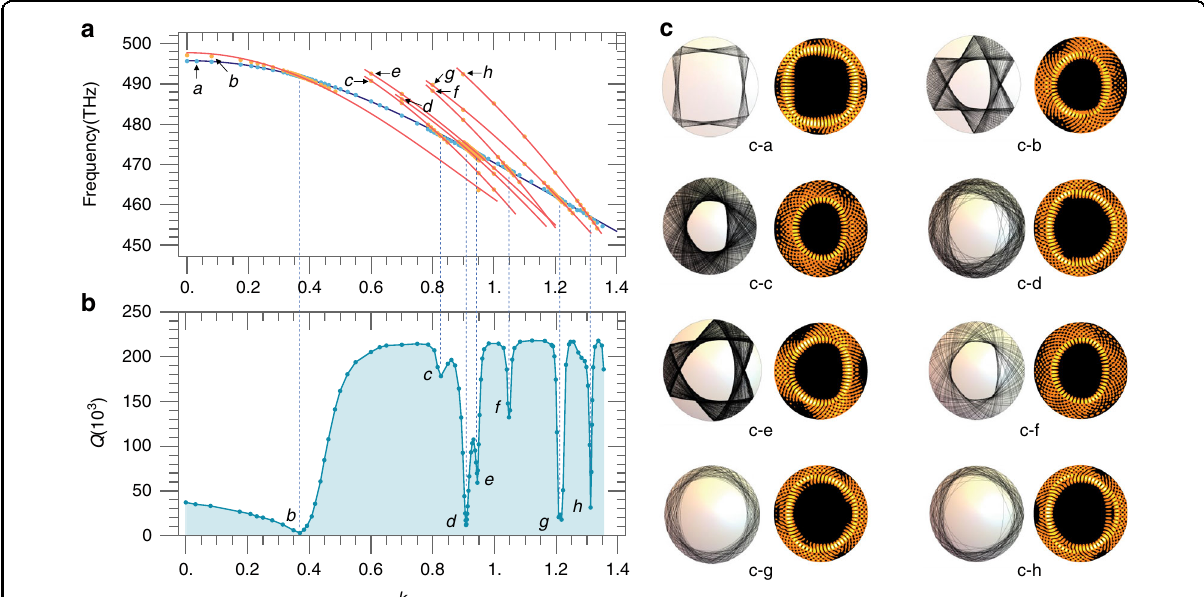
Fig. 2 Features of various photonic modes in topologically curved microcavities. a – h labels modes of different origins. a The frequency of modes a-h as a function of k . b The Q-factor of mode a (which is a 4-period island mode) as a function of k , showing a series of dips corresponding to the resonant point with other modes (labeled with the corresponding letters). c Light trajectories [left panels of ( c – a ) to ( c – h )] and electric fi eld spatial pro fi les [right panels of ( c – a ) to ( c – h )] of modes a – h (top view). Each graph in c corresponds to the point in a pointed by the arrow with